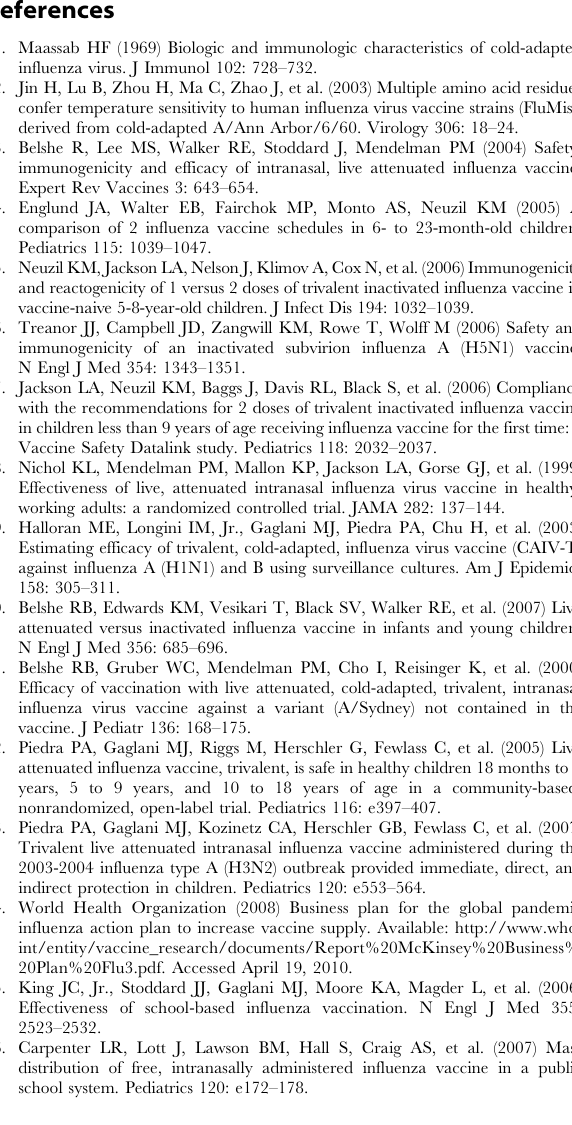
Table S1 Adverse Events Reported in Children # 15 Days After Dose (Safety Population).